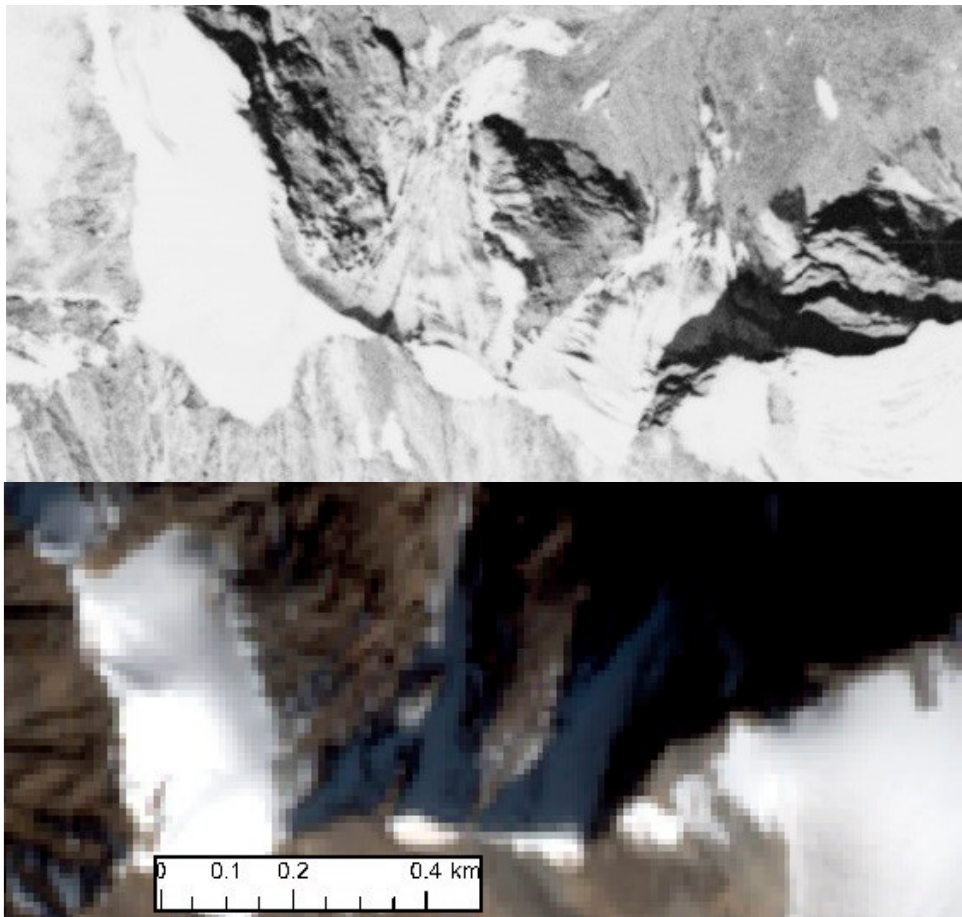
Figure 5. Degradation of hanging glaciers in the Maashei river basin. Above: Corona image fragment (CORONA, 1968/08/10); below: Sentinel 2 image fragment (2021-09-08).